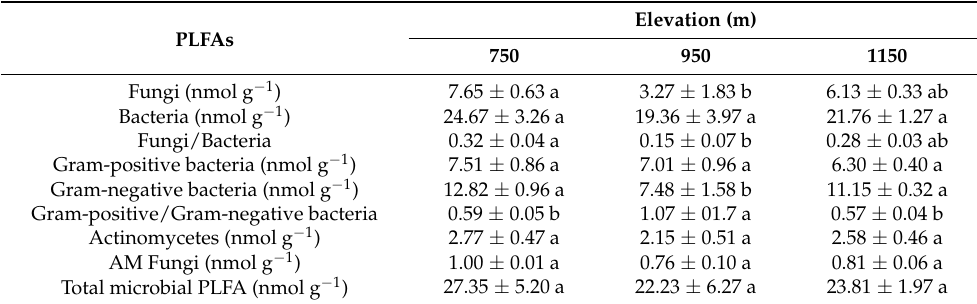
Table 2. PLFAs of soils at different elevations. The data are expressed as the means ± SE ( n = 4). Different letters followed data in the same row denote significant difference at p <